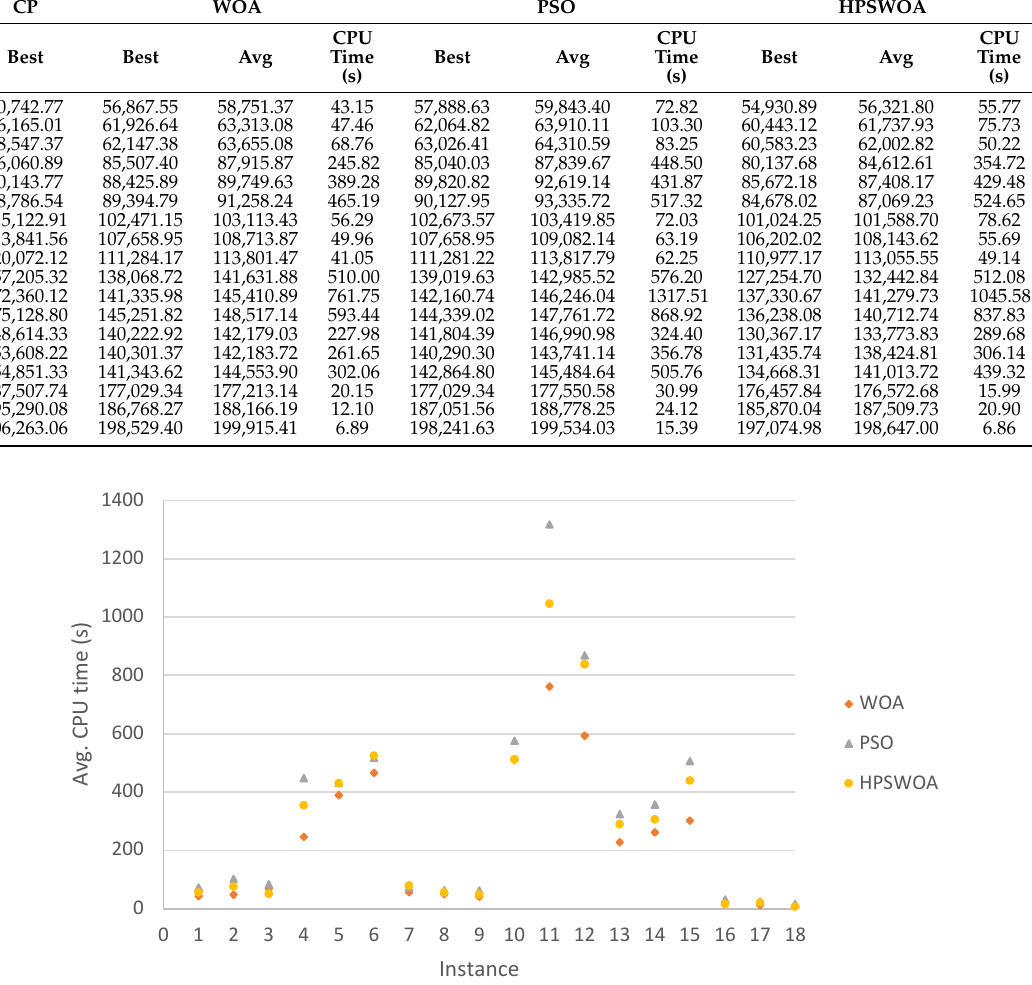
Table 8. Statistical test results for the best total cost obtained from Table 6.